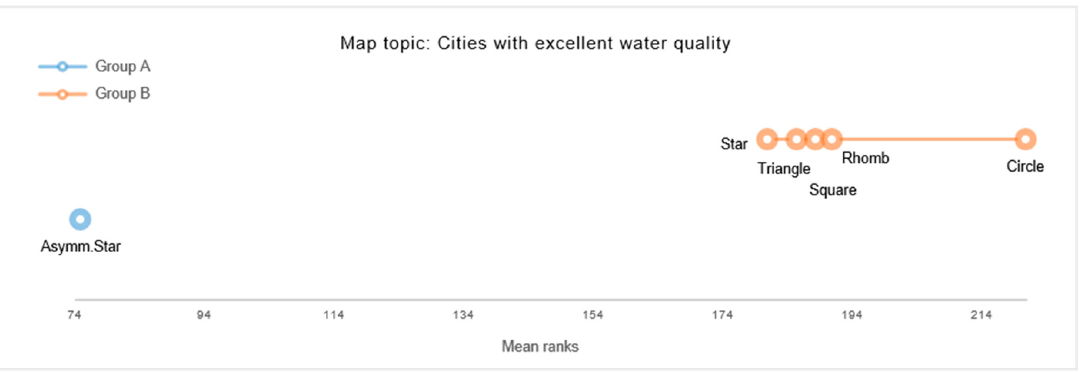
Figure 8. Map #4: Results of multiple pairwise comparisons, indicating groups of (dis)similar symbol-content congruence.